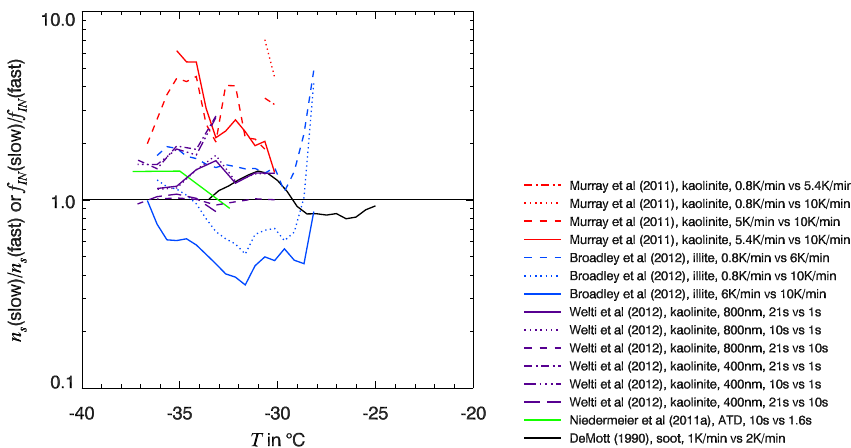
Fig. 16. Ratio of INAS densities or ice fractions in experiments with different cooling rates or residence times, but the same aerosol. The data from Murray et al. (2011), their Fig. 6a, and Broadley et al. (2012), their Fig. 6b, are binned into intervals of 0.5K and compared for overlapping temperature ranges. For Broadley et al. (2012), the experiments with cooling rates of 7.5Kmin − 1 , 5Kmin − 1 and 1Kmin − 1 are not included here because of the large spread in the data. The data shown from Niedermeier et al. (2011b) represent the three data points for which experiments with a nucleation time of 10s were conducted (their Fig. 1). For soot, two experiments with 0.08µm particles are compared (DeMott, 1990, his Fig. 5).